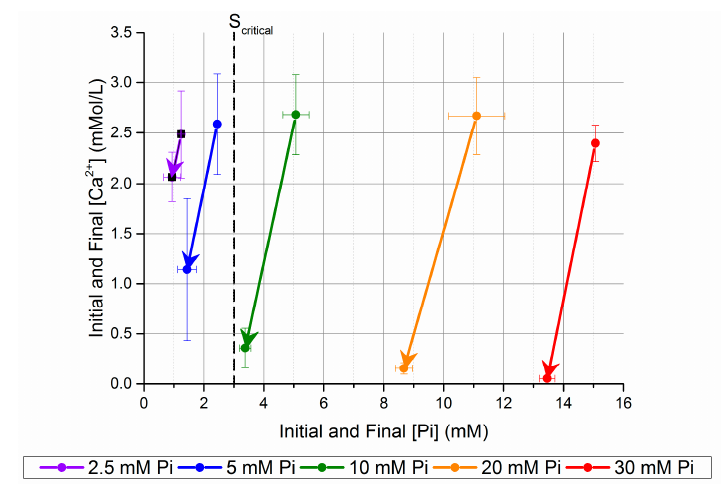
Figure 2. Change in [Ca 2+ ] and [Pi] after five days in unseeded batch precipitation. The samples are named after the [Pi] before mixing with the Ca-CO 3 solution.